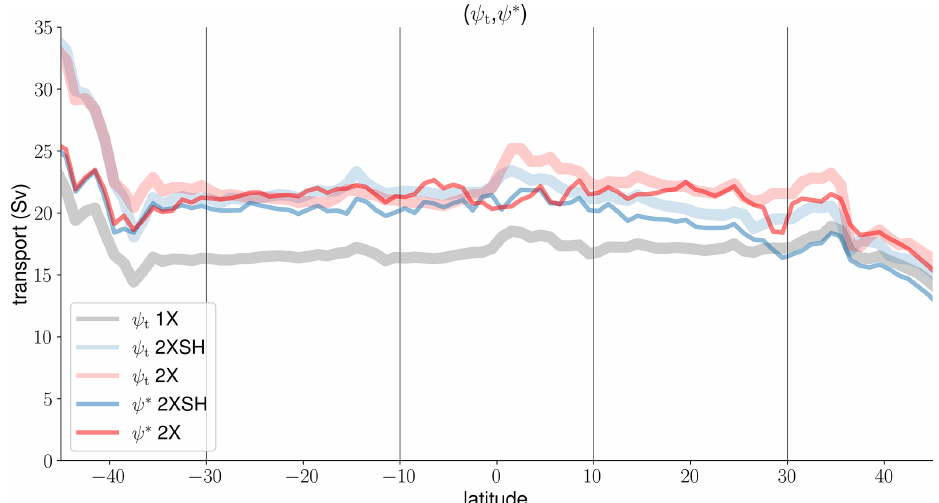
Figure 9. The total maximum overturning streamfunction ψ t and the maximum overturning streamfunction ψ ∗ in the case that we use the 2 ψ time-mean vertical velocity shear ∂ of the 1X reference experiment and the changes in the level of no motion from the 2XSH and 2X ∂z 2 experiments to integrate the vertical shear